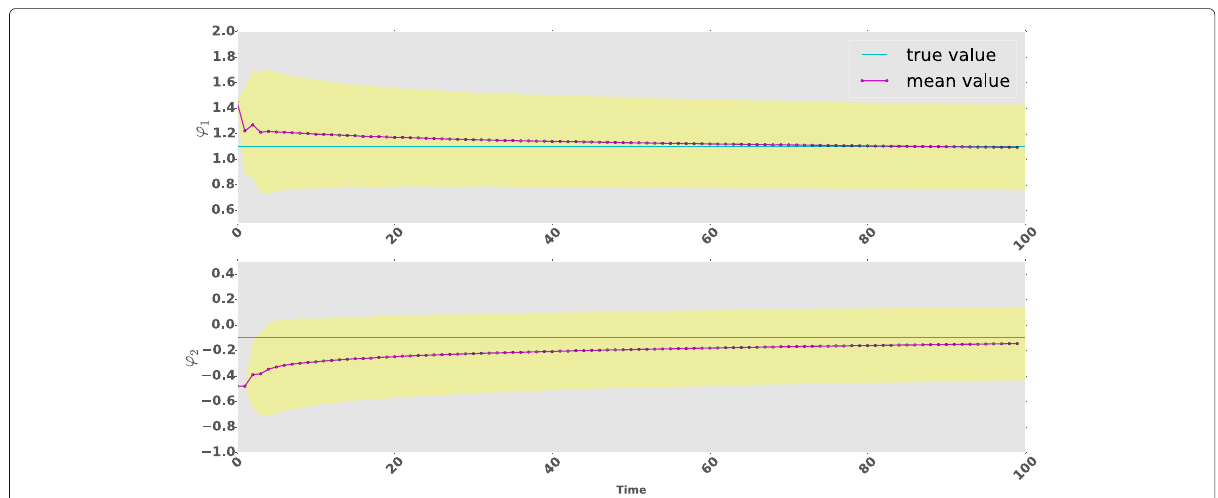
Fig. 1 Estimation results of ARMA(2,0) process with parameters ϕ = [1.15, − 0.15] and σ 2 = 0.01 for initial value parameters ϕ = [1.5, − 0.5] and σ 2 = 10 with 10,000 realizations and length of the data t = 100. With yellow color, the area of standard deviation is shown